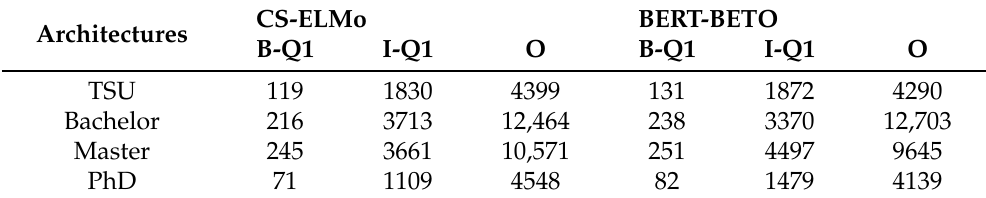
Table 6. Detection results for question Q2: Why is it going to be done?